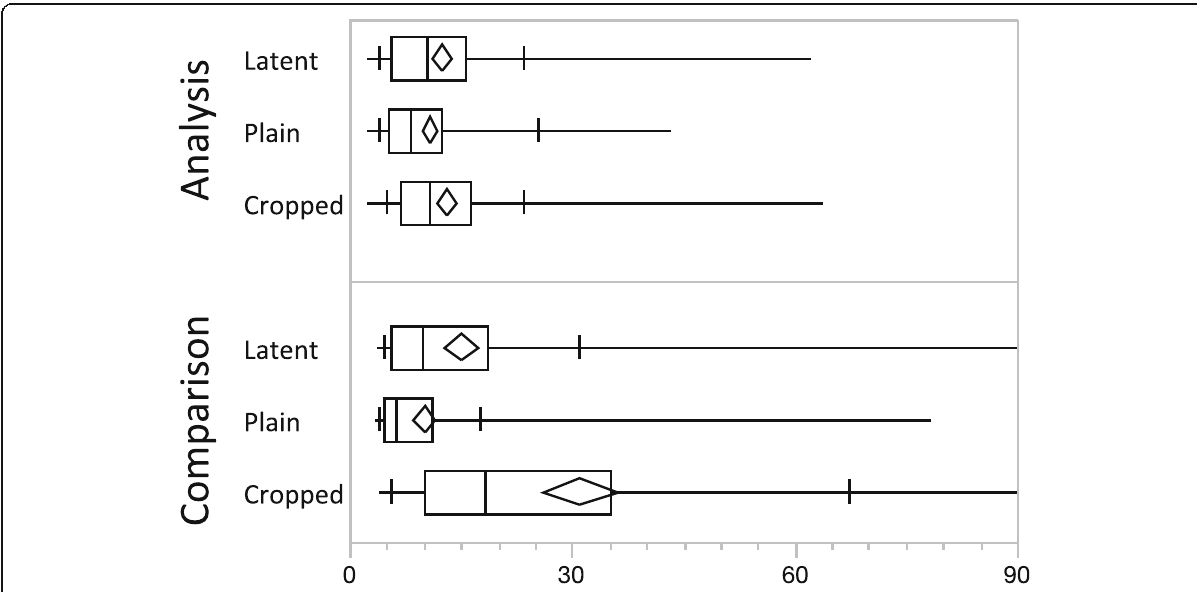
Fig. 6 Total Analysis and Comparison times. Analysis medians (seconds): Latent = 10.2; Plain = 8.1; Cropped= 10.7. Comparison medians (seconds): Latent = 9.7; Plain = 6.1; Cropped = 18.2. Crossbars indicate 10% and 90% deciles. Maximum Comparison times (not shown): Latent 152 s (1% of trials > 90 s); Cropped 281 s (7% of trials > 90 s). ( n = 675